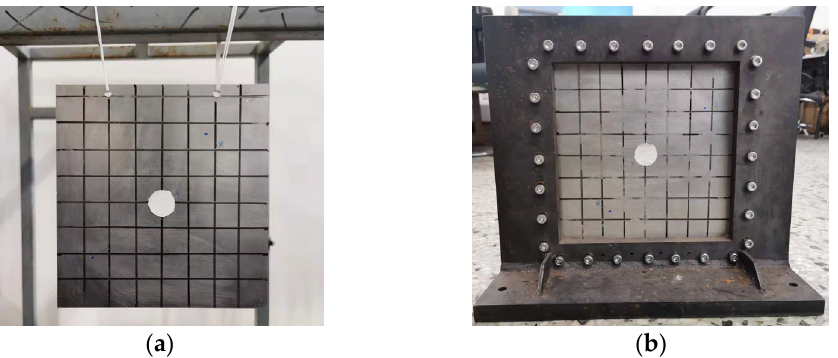
Figure 7. The experimental setup: ( a ) hammer; ( b ) accelerometer sensor; (c) charge adapter; ( d ) dynamic data acquisition instrument; (e) computer.